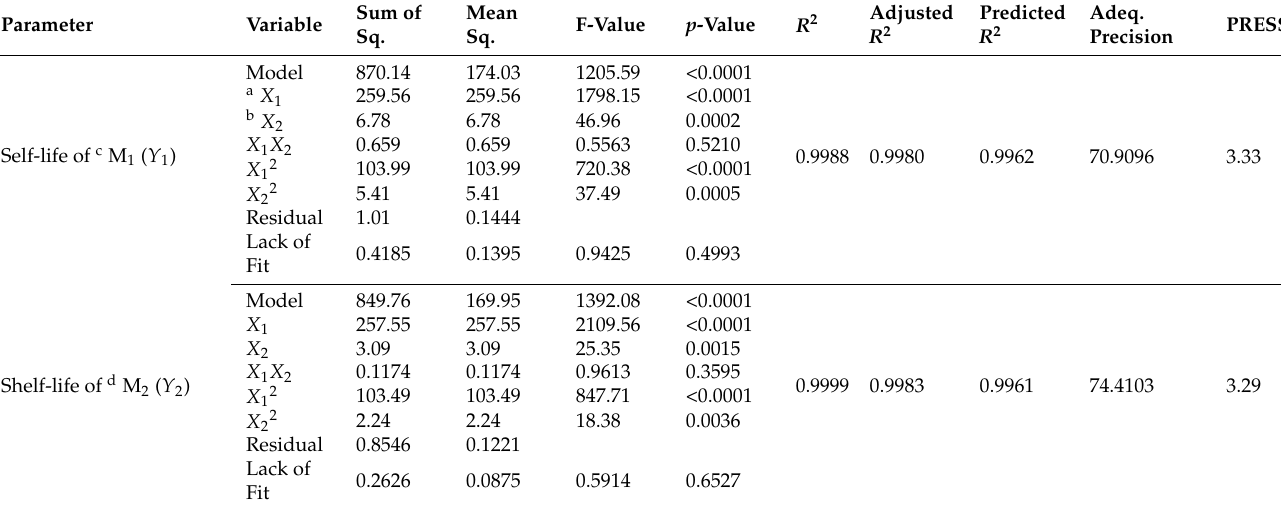
Table 6. Model variables and ANOVA results for shelf-life of mushrooms (days) stored at 4 ◦